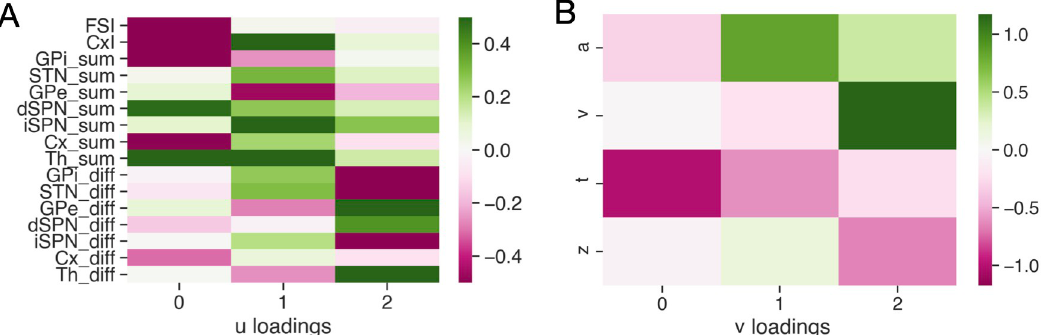
Fig 7. Canonical loading matrices obtained by applying the CCA to the mapping R ! P . A) The loadings corresponding to the firing rates, R . B) The loadings corresponding to the DDM parameters, P . In both panels, the values of matrix entries are represented by the color bars, and the color code indicates the magnitude and sign of the